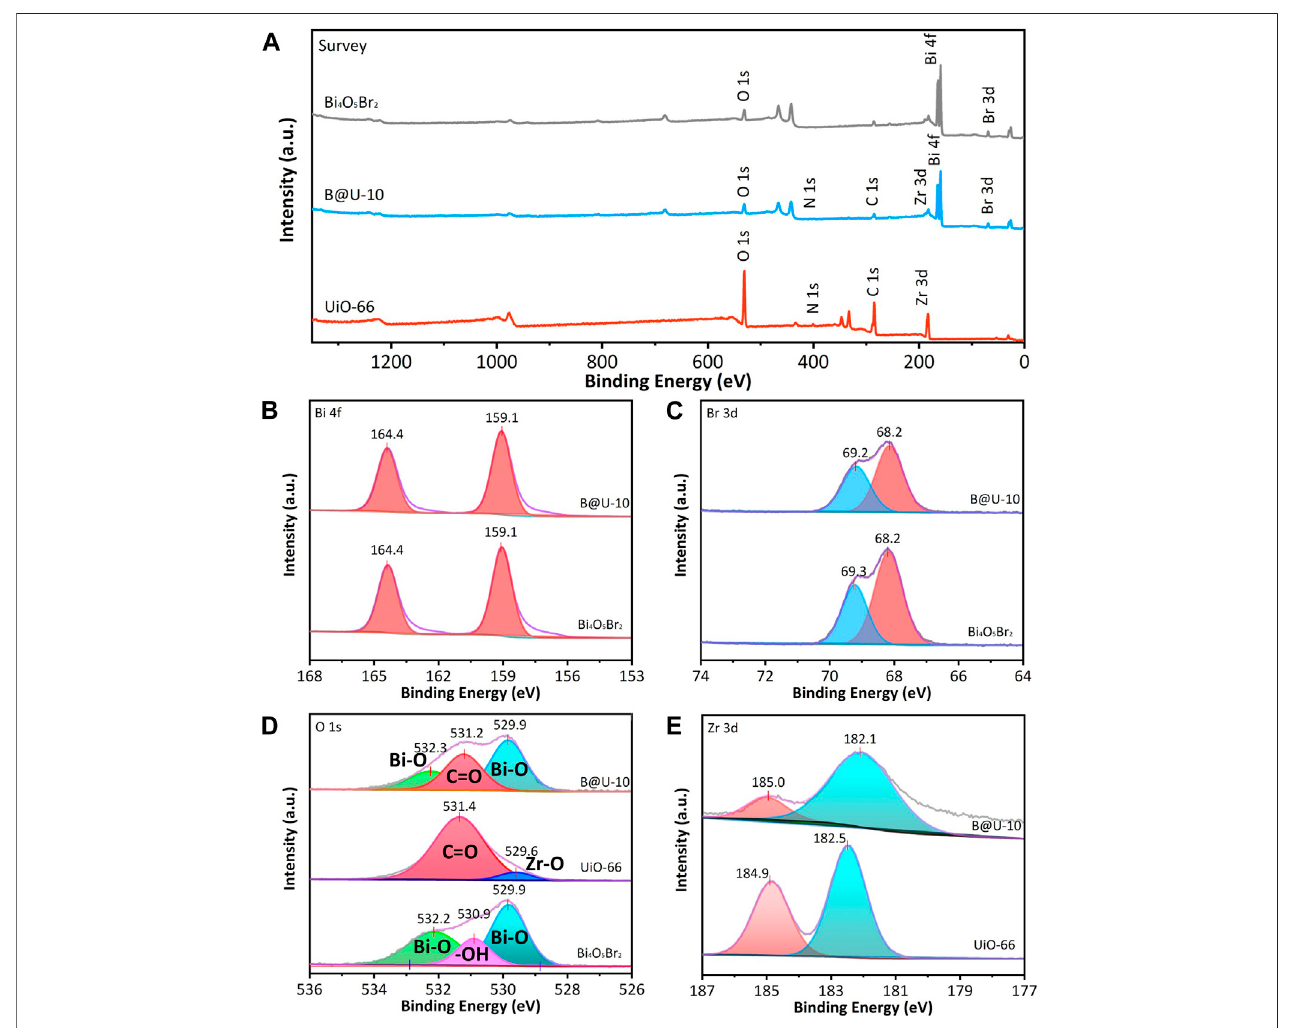
FIGURE 2 | XPS survey spectra (A) , high-resolution spectra of (B) Bi 4f, (C) O 1s, (D) Br 3d, and (E) Zr 3d for UiO-66, Bi 4 O 5 Br 2 , and U@B-10.